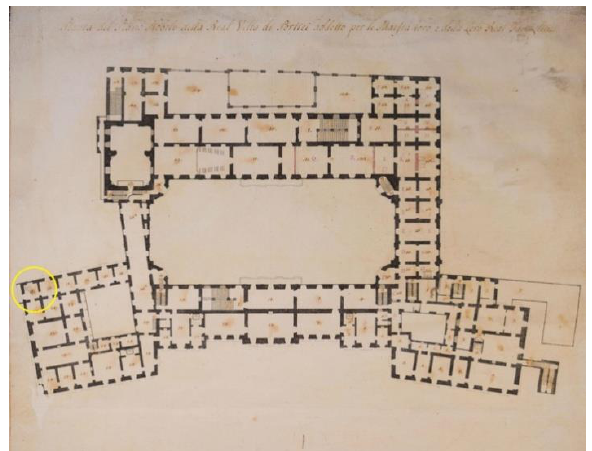
Figure 2. Historic plan of the royal palace in Portici. Main floor with the position of the Gabinetto of gilded stucco (ASNa, Piante e disegni , X-27).